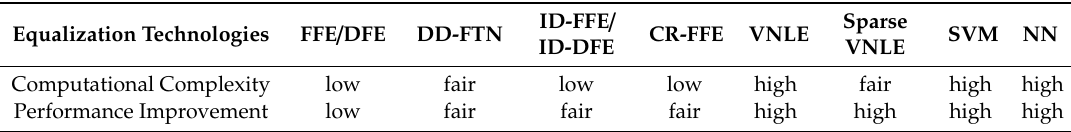
Table 4. Comparison of the computational complexity and performance improvement for di ff erent equalization